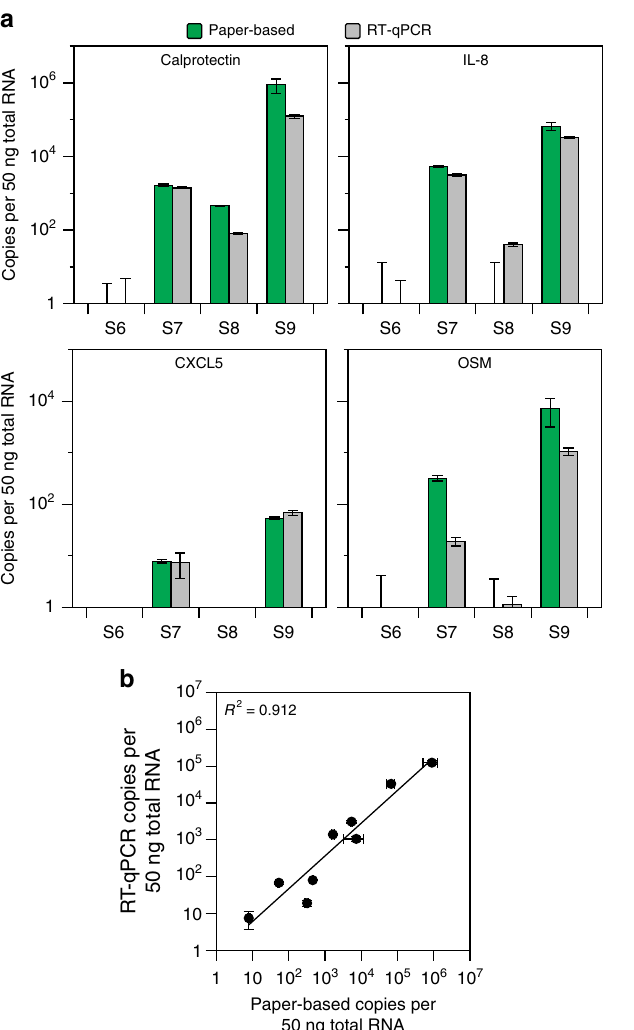
Fig. 5 Detection of host biomarkers of in fl ammation. a Analysis of clinical stool samples. Four clinical stool samples were processed for total RNA and analyzed by our paper-based platform and RT-qPCR. Data represent mean values. Paper-based error bars represent s.d. from nine replicates (three biological replicates (NASBA reactions) × three technical replicates (paper- based reactions)). RT-qPCR error bars represent s.d. from six replicates